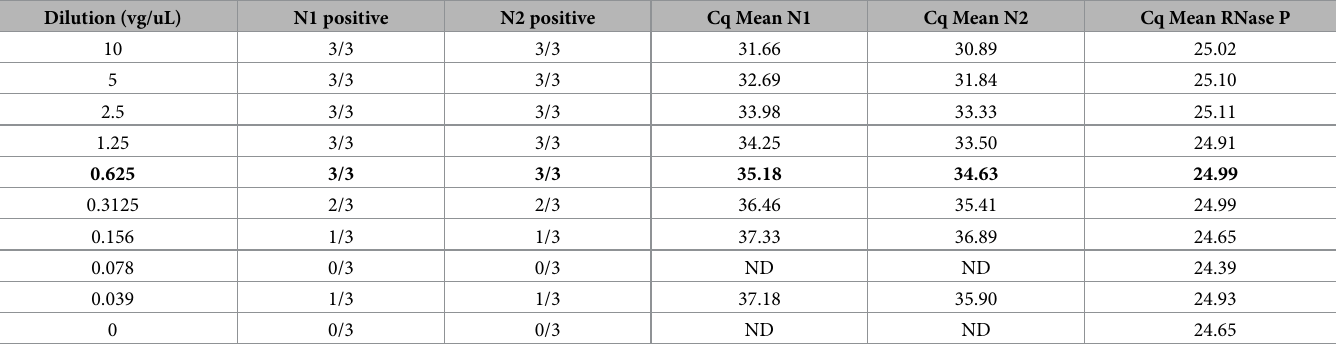
Table 1. The limit of detection for the UC Santa Cruz Multiplex SARS-CoV-2 assay. Dilution